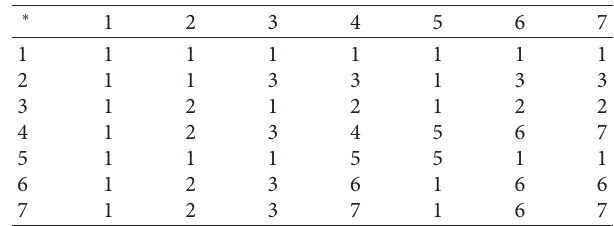
Table 3: Table of Example 3.